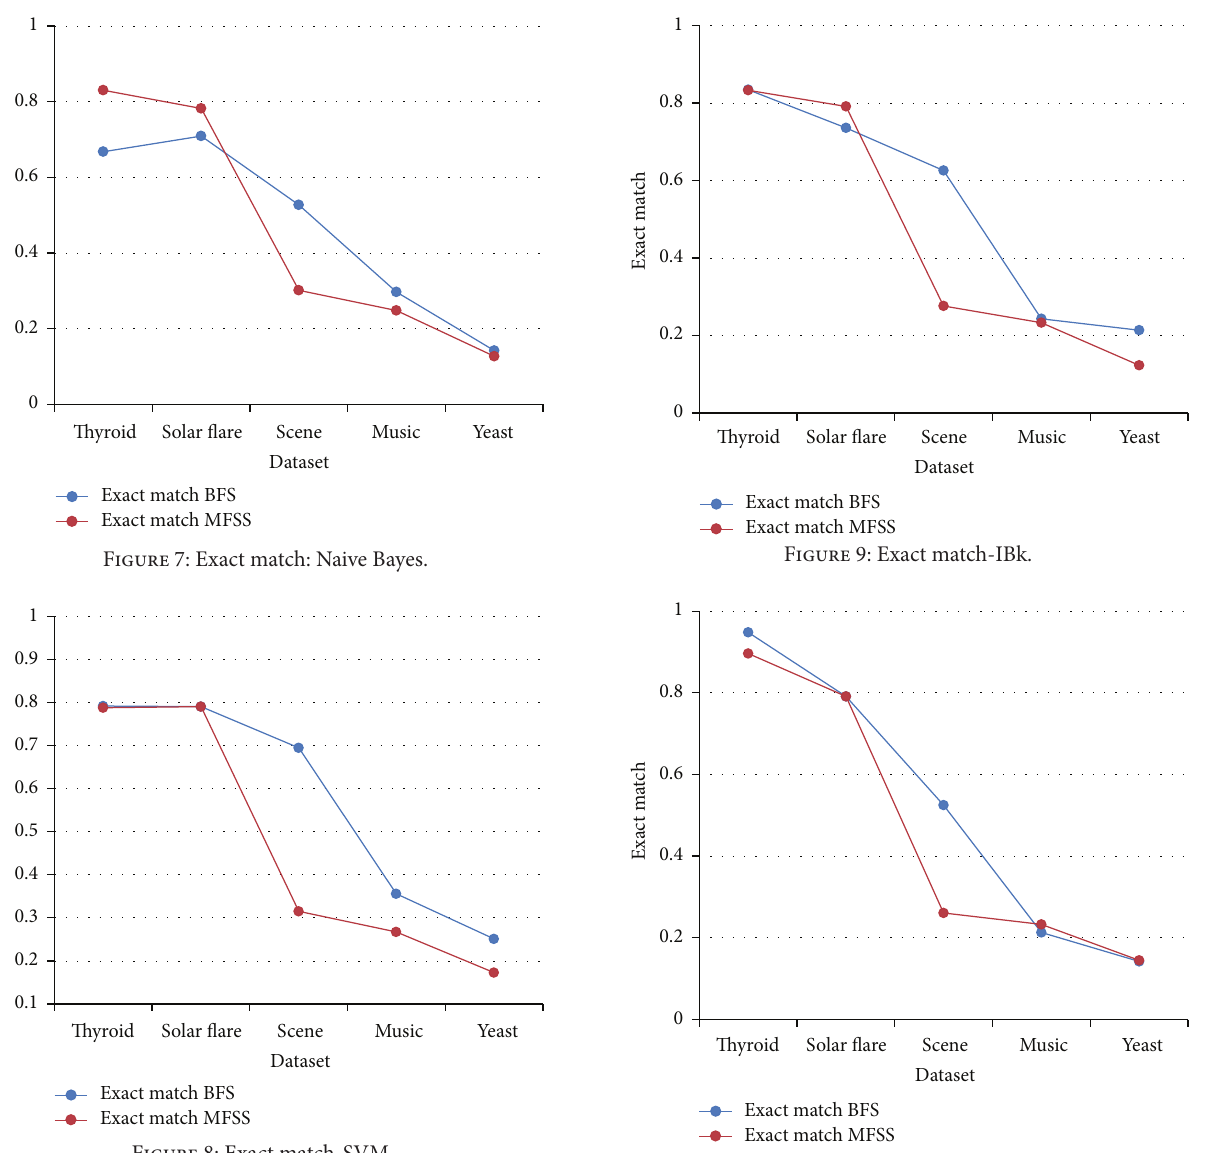
Figure 7: Exact match: Naive Bayes.